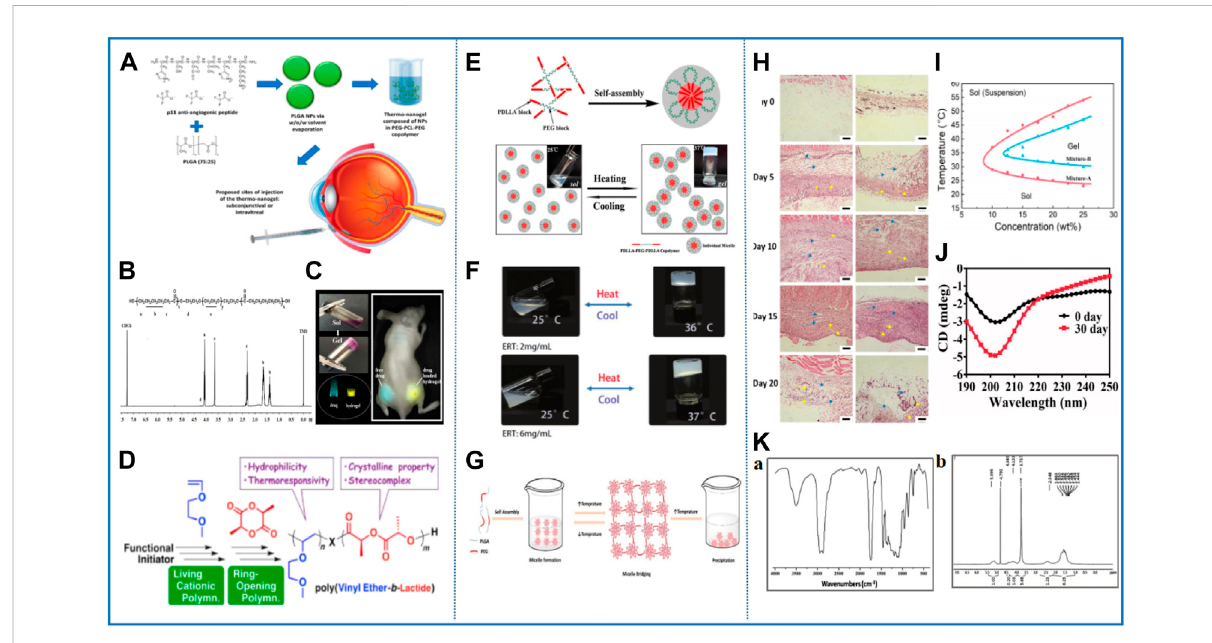
FIGURE 4 Representative studies of thermosensitive nanomaterials based on polyester. (A) Componential formulation and proposed delivery of the thermo-nanogel system. Reprinted with permission from du Toit et al. (2021). Copyright © 2021 Pharmaceutics. (B) Structure and 1 H-NMR spectrum of PCEC copolymer. Reprinted with permission from Qu et al. (2018). Copyright © 2018 American Chemical Society. (C) Thermosensitive hydrogel withaprotoporphyrincorebasedonaPEGandPCLcopolymer(PCL-PEG-PPOR-PEG-PCL)asapotentialvisiblebiomedicalimplant.Reprinted with permission from Dong et al. (2016). Copyright © 2016 American Chemical Society. (D) New class of polylactide (PLA)-based block copolymers with thermoresponsive poly (vinyl ether) [poly (VE)] were precisely synthesized via successive living cationic polymerization of VE and ring-opening polymerization of lactide. Reprinted with permission from Seki et al. (2018). Copyright © 2018 American Chemical Society. (E) Schematic diagram of the process of temperature-induced physical gelation of the amphiphilic block copolymers. Reprinted with permission from Shi et al.